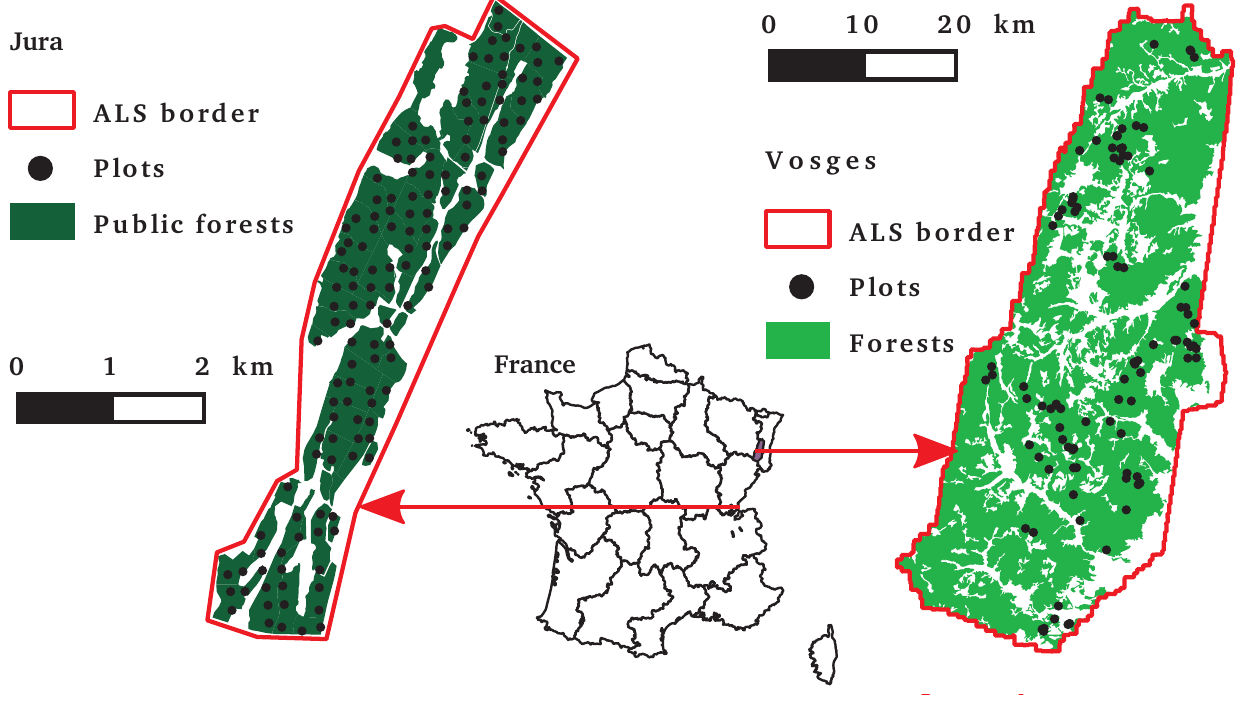
Figure 1. Location of the study areas and the positions of forest inventory